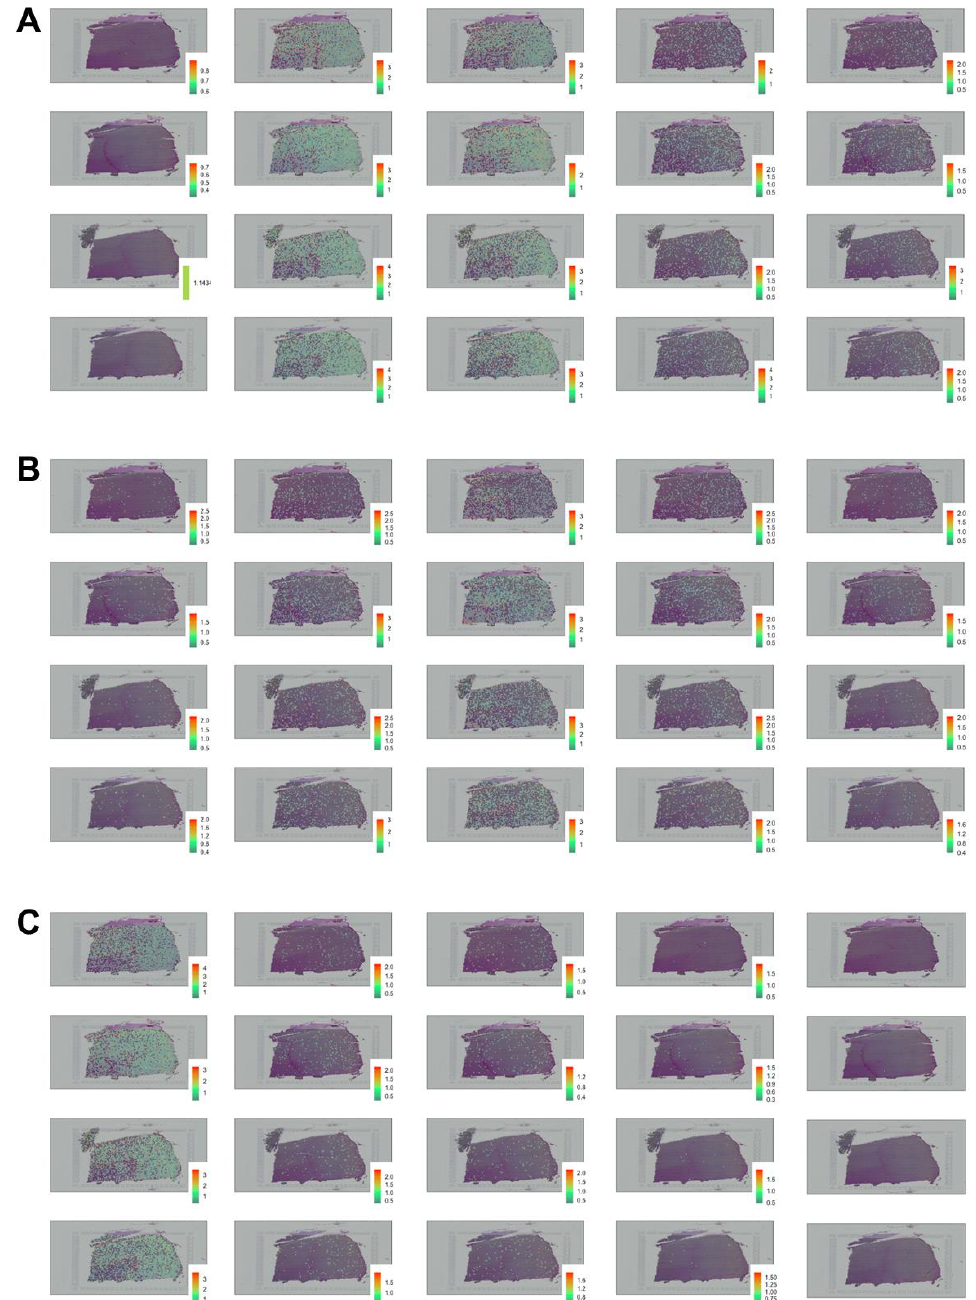
Figure 2. Spatial distribution of docking, processing, and viral defense genes involved in SARS-CoV-2 brain entry. (( A ), from left to right) Spatial distribution of ACE2 , BSG , CTSB , CTSL , and FURIN across four DLPFC samples plotted column-wise and mapped as illustrated in Figure 1. (( B ), from left to right) Spatial distribution of IFITM1 , IFITM2 , IFITM3 , IFNAR1 , and IFNAR2 across four DLPC samples plotted column-wise and mapped as illustrated in Figure 1. (( C ), from left to right) Spatial distribution of LY6E , NRP1 , NRP2 , TMPRSS2 , and TMPRSS11A across four DLPC samples plotted column-wise and mapped as illustrated in Figure 1.